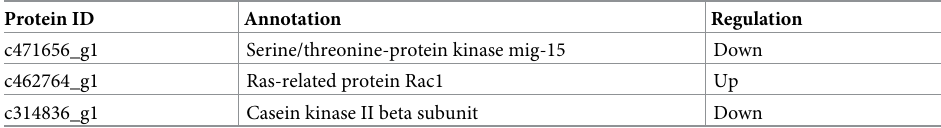
Table 1. DAPs involved with phosphorylation in ND1 vs D1 comparison based on GO